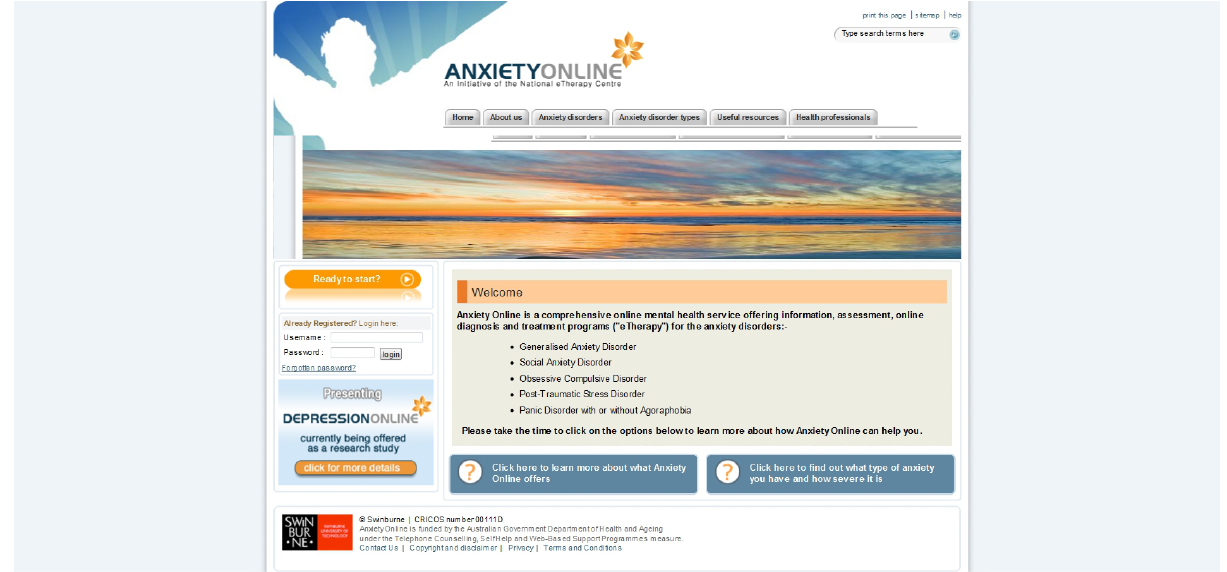
Figure 1. Homepage of Anxiety